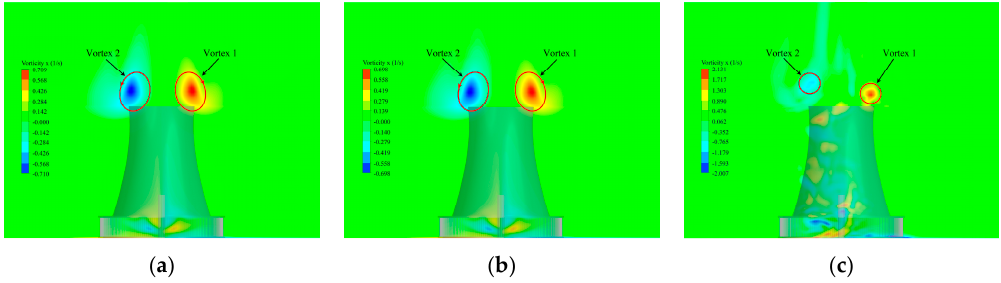
Figure 24. Comparisons of the component of vorticity in the x direction at 100 m downstream of cooling tower (x = 100 m) : ( a ) RANS; ( b ) URANS; ( c ) LES.